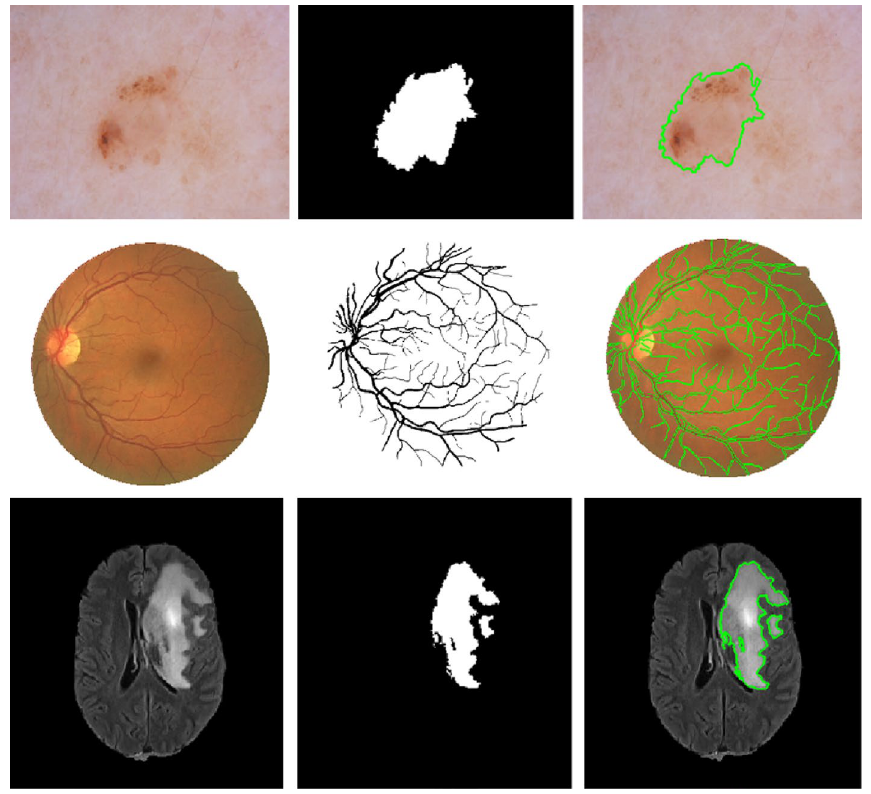
Figure 1. Exemplary pairs of the original medical images and their ground-truth segmentation